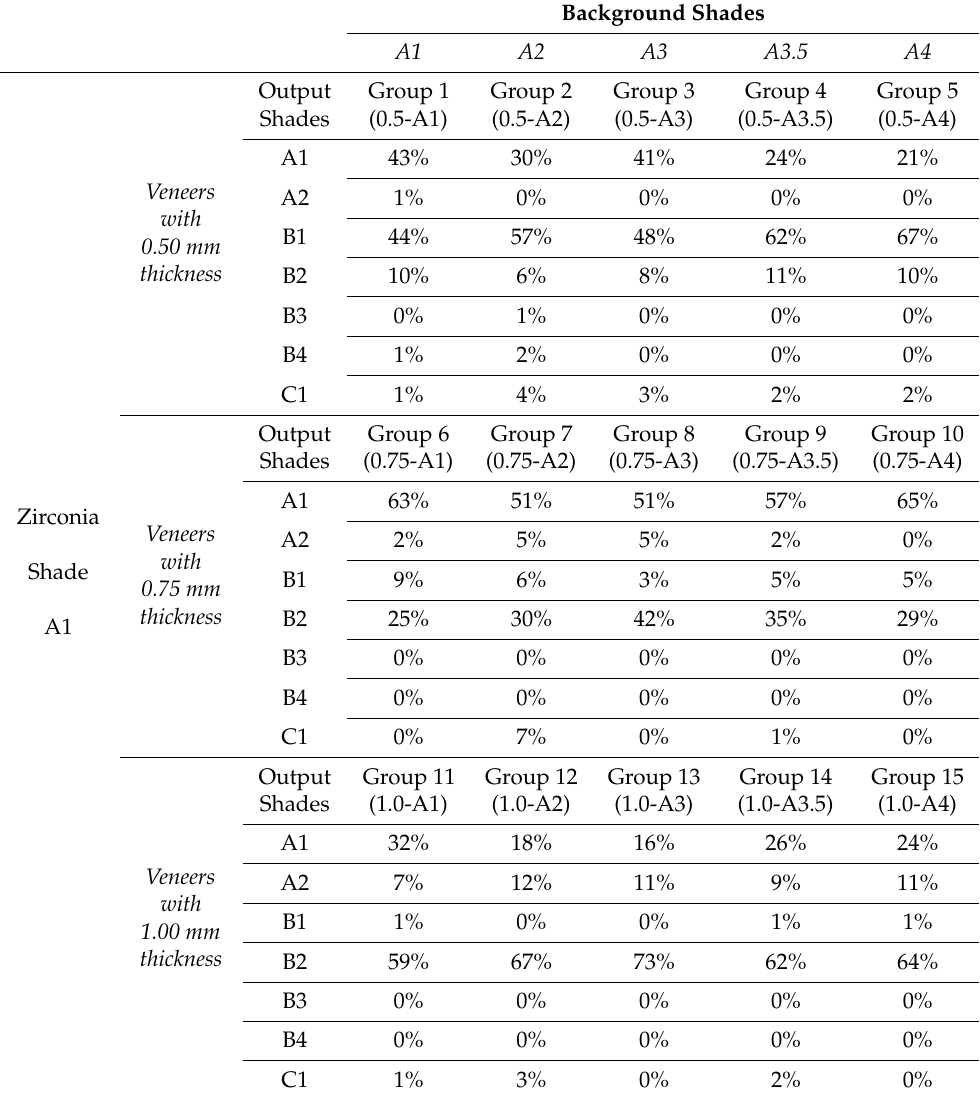
Table 4. Summary of the percentage distribution of output shades across different subgroups of background shades after adjusting for veneer